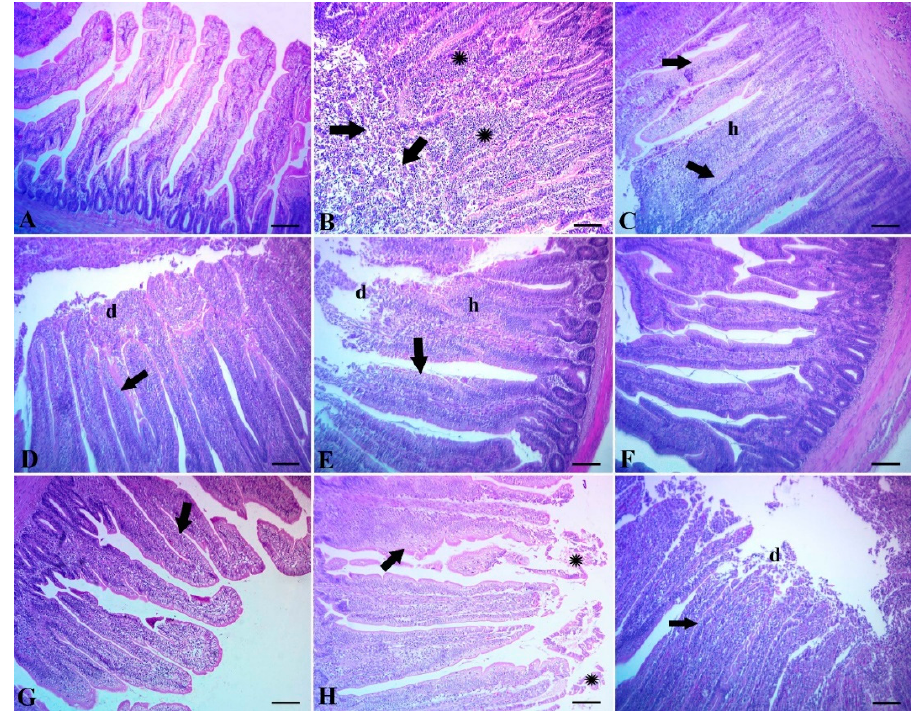
Figure 3. ( A ) Intestine of the control group without Clostridium challenge, showing normal tissue Figure 3. (A) Intestine of the control group without Clostridium challenge, showing normal architecture with normal intestinal villi. ( B ) The intestine of chicks subjected to Clostridium challenge, tissue architecture with normal intestinal villi. (B) The intestine of chicks subjected to showing an extensive degeneration and necrosis of the intestinal villi (arrows) with extensive round cell Clostridium challenge, showing an extensive degeneration and necrosis of the intestinal villi aggregations ( ∗ ) . ( C ) The intestine of Clostridium -challenged chicks showing extensive hyperplasia of (arrows) with extensive round cell aggregations ( ⁕ ) . (C) The intestine of Clostridium - the villous epithelium (h) with thickening and shortening of villi, together with metaplasia into goblet challenged chicks showing extensive hyperplasia of the villous epithelium (h) with cells (arrows). ( D ) The intestine of Clostridium -challenged chicks, showing an extensive degeneration thickening and shortening of villi, together with metaplasia into goblet cells (arrows). (D) of the villous epithelium (d) with metaplasia of the columnar epithelium into goblet cells (arrow). ( E–I ) Intestine of chicks challenged with Clostridium ) and supplemented with: ( E Maxus, showing extensive hyperplasia of intestinal epithelium (h) , metaplasia into goblet cells (arrow) and moderate desquamation of superficial epithelium (d) ; ( F ) Clostat, showing a regeneration of the intestinal epithelium with normal tissue architecture; ( G ) Sangrovit, showing a normal tissue architecture with moderate metaplasia of the intestinal epithelium into goblet cells (arrow); ( H ) Clostat + Sangrovit, showing a sloughing of the superficial epithelium ( ∗ ) with moderate metaplasia into goblet cells (arrow); ( I ) Gallipro, showing a severe desquamation of the superficial epithelium (d) and metaplasia into goblet cells (arrow). Scale bar = 100 µ